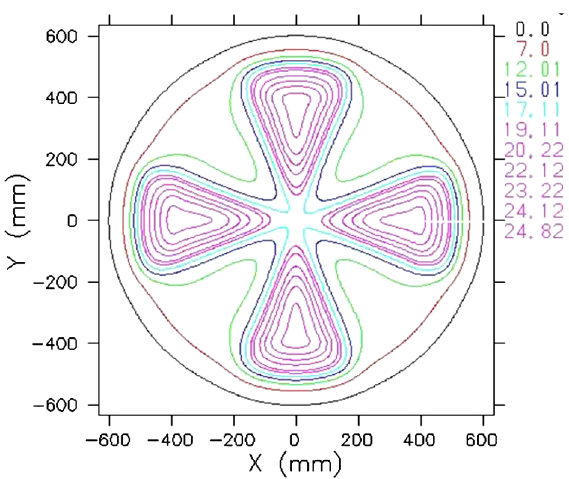
FIG. 3. Contour plot of median plane magnetic field. Contour values (kG) are listed on the right side.